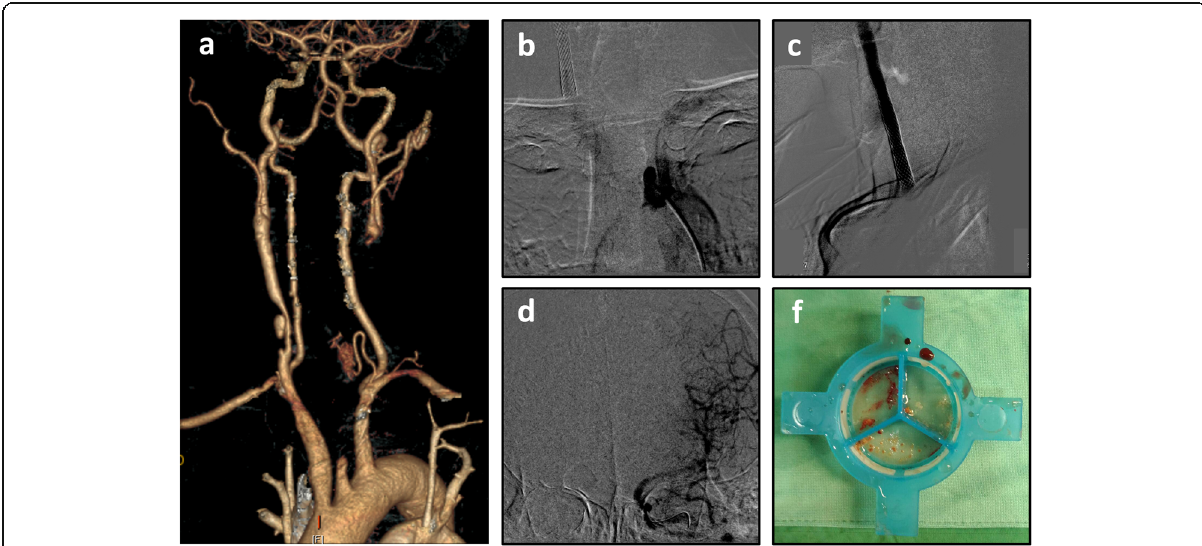
Fig. 2 Patient 2 computed tomography angiography ( a ). Angiography ( b ). Final angiography ( c ). Intracranial angiography after the intervention ( d ). Thrombus ( e